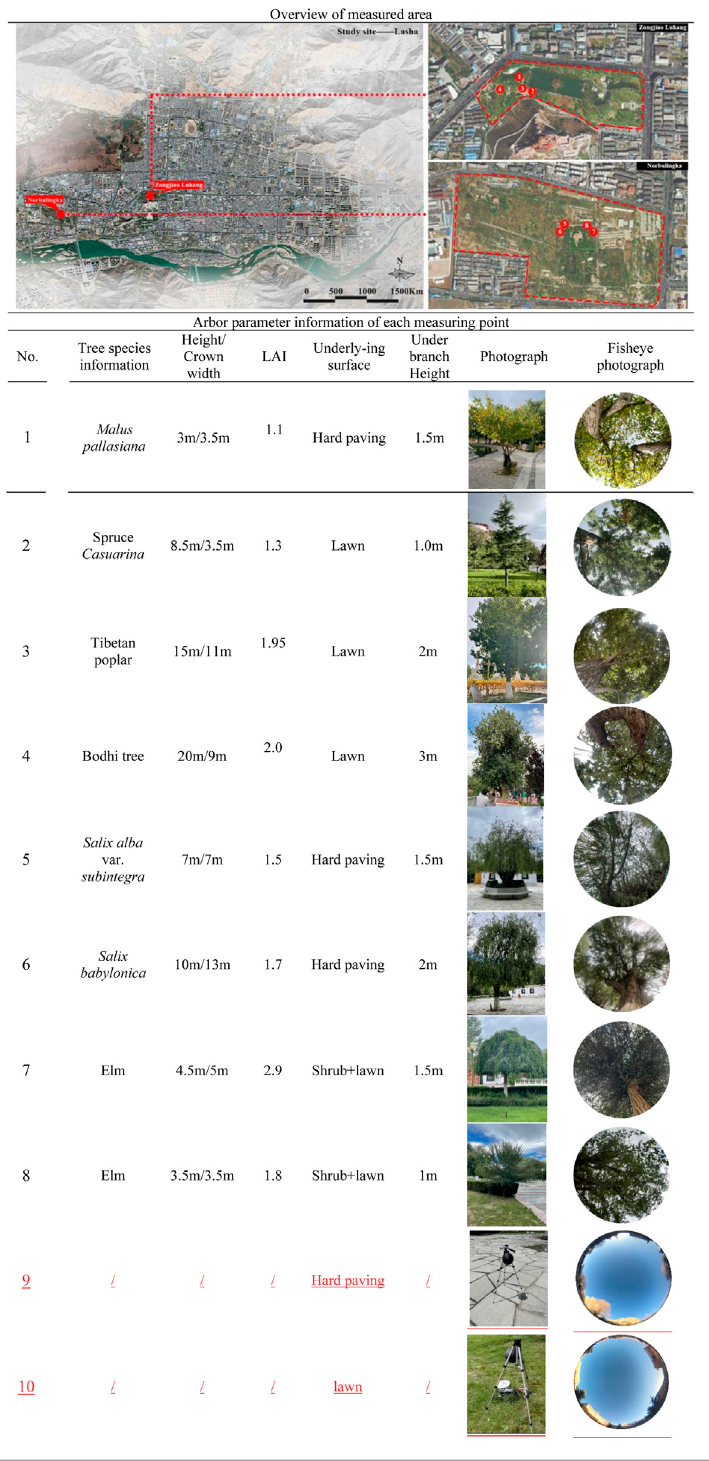
TABLE 1 Measuring point